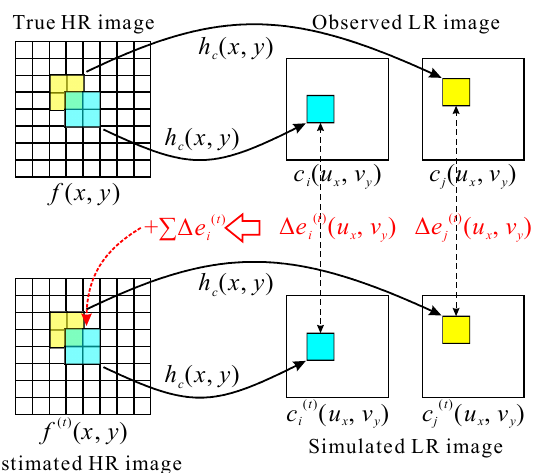
Figure 4. SR by the Irani and Peleg